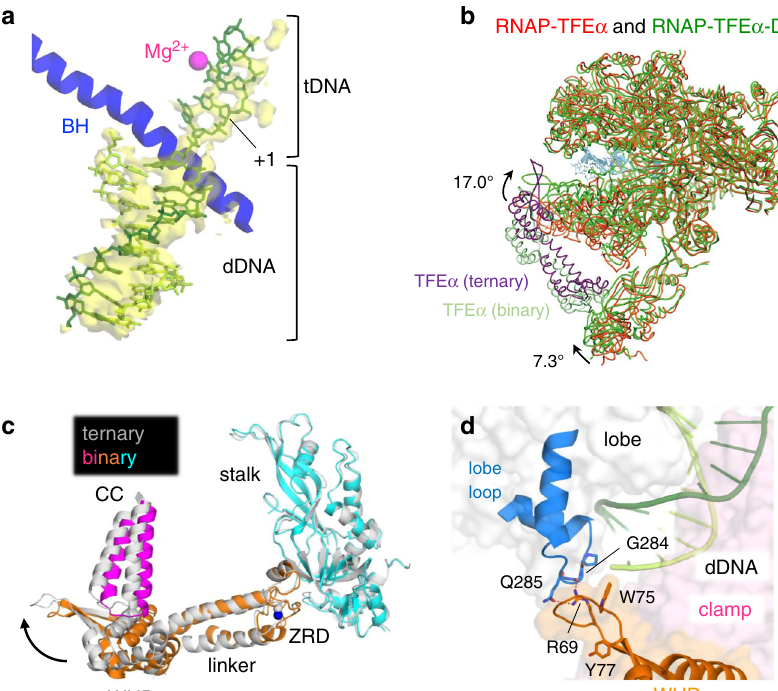
Fig. 4 DNA interaction with RNAP in the presence of TFE α . a Close-up view of the DNA binding channel of the RNAP – TFE α – DNA complex is shown with the cryo-EM density map (yellow and transparent) of DNA. DNA is shown as a stick model (template DNA, dark green; non-template DNA, light green). Template DNA strand (tDNA), downstream double-stranded DNA (dDNA) and transcription start site ( + 1) are indicated. Mg 2 + bound at the active site of RNAP and bridge helix (BH) are depicted. b The structures of the RNAP – TFE α binary (red) and the RNAP – TFE α – DNA ternary (green) complexes are superimposed. The conformational changes of the clamp and stalk by DNA positioning in the ternary complex are indicated. c Conformational change of TFE α upon RNAP binding DNA. The ZRD of TFE α was used as a reference to superimpose the RNAP and TFE α in the binary (color) and ternary complexes (light gray), revealing movement of the eWHD of TFE α together with the RNAP clamp indicated by an arrow. d Close-up view of the RNAP lobe and TFE α wing interaction. Amino acid residues involved in the RNAP lobe and TFE α wing interaction are depicted as stick models and indicated. Surface exposed aromatic residues (W75 and Y77) of TFE α involved in the DNA interaction are also